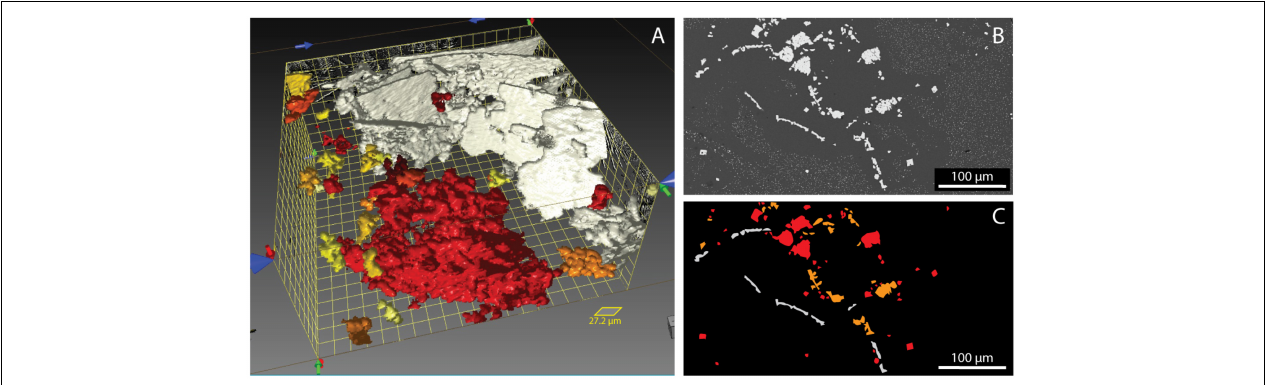
FIGURE 4 | Images displaying features associated with the spinels. (A) 3D reconstruction, performed using Dragonfly software, of newly formed spinel (in white) and already present spinel (in red) in the sample deformed at 2 × 10 − 5 s − 1 at t = 260 min. The different colors represent the aspect ratio of the crystals and are used here only for visualization purposes. (B) Elongated spinel crystals nucleated during deformation [white crystals in panel (C) ] and vermicular spinel crystals already present [colored crystals in panel (C) ] grew during deformation and have an aureole of microlite-free melt visible in SEM